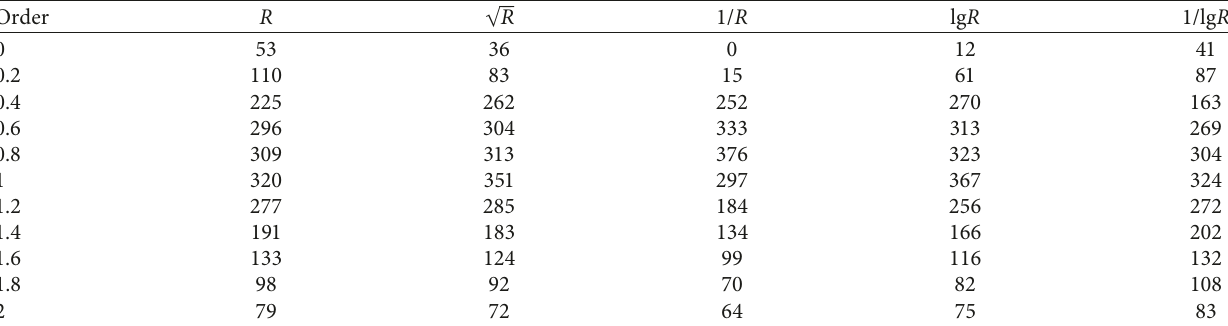
Figure 3: Correlation coefficient of fractional derivative-processed raw spectral reflectance data and SOM content. (a) Zeroth order. (b) 0.2 order. (c) 0.4 order. (d) 0.6 order. (e) 0.8 order. (f) First order. (g) 1.2 order. (h) 1.4 order. (i) 1.6 order. (j) 1.8 order. (k) Second order. Table 1: Number of bands passing the significance test of 0.05.